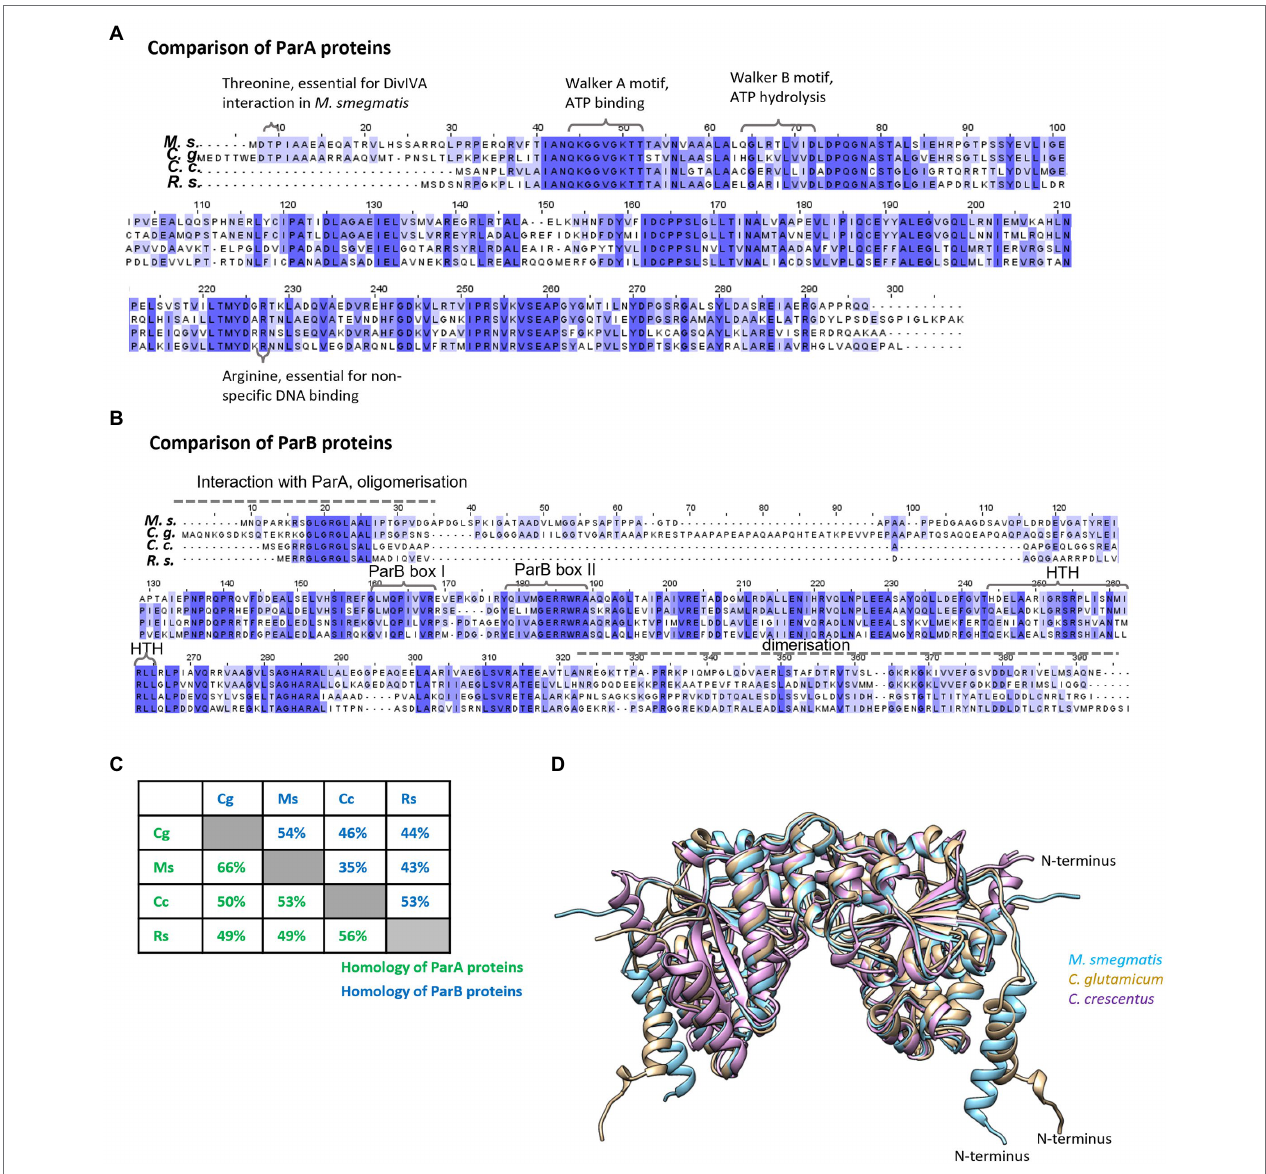
FIGURE 1 | Homologies between ParA and ParB proteins from two Pseudomonadota species, Caulobacter crescentus and Rhodobacter sphaeroides , and two Actinomycetota species, Mycobacterium smegmatis and Corynebacterium glutamicum. (A) Sequence alignment of ParA proteins from M. smegmatis (Ms) , C. glutamicum (Cg) , and C. crescentus (Cc) and ParA1 from R. sphaeroides (Rs) aligned by Clustal Omega, visualised in Jalview, and coloured by BLOSOM62 score. Amino acids and motifs engaged in interactions are marked. (B) Sequence alignment of ParB proteins from M. smegmatis (Ms) , C. glutamicum (Cg) , and C. crescentus (Cc) and ParB1 from R. sphaeroides (Rs) aligned by Clustal Omega, visualised in Jalview, and coloured by BLOSOM62 score. Motifs engaged in interactions are marked. (C) Protein identities calculated in BLASTp. The green and blue numbers show identity between ParA and ParB proteins, respectively, from different species [ M. smegmatis (Ms), C. glutamicum (Cg), C. crescentus (Cc), and R. sphaeroides (Rs)]. (D) The structure of ParA dimer proteins predicted by AlphaFold Colab (Jumper et al., 2021) compared and visualised by Chimera program (Pettersen et al., 2004). The blue colour indicates M. smegmatis ParA, brown— C. glutamicum ParA and violet— C. crescentus ParA. N-terminal of ParA from one monomer is